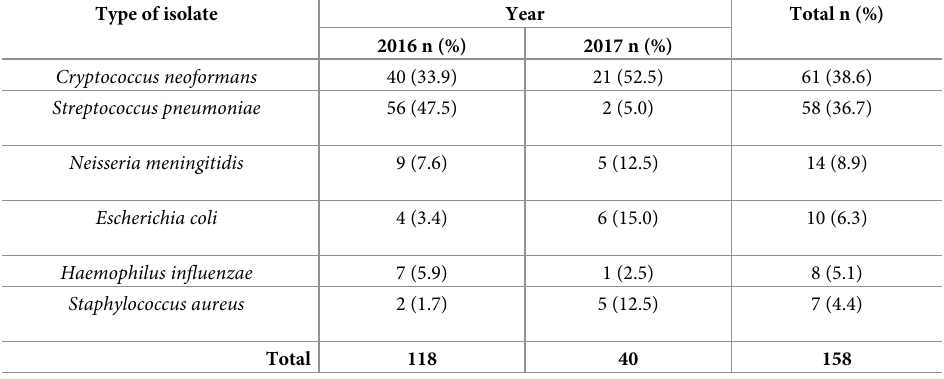
Table 1. Frequency of the pathogens causing bacterial and fungal meningitis among adults in Mozambique 2016–